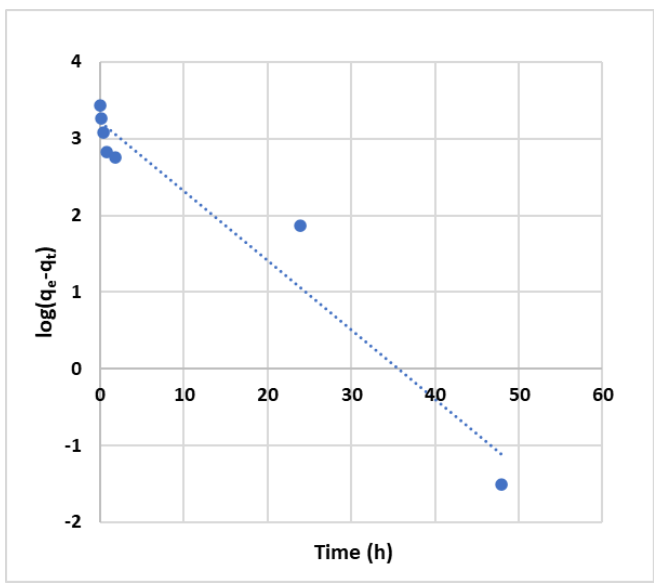
Figure 15. The model plot of pseudo-first-order for the CR dye adsorption onto 2Clph-BU-Cs adsorbent (m = 0.01 g, C 0 = 100 mg L −1 , V = 50 mL, pH = 4, and T = 298 K).